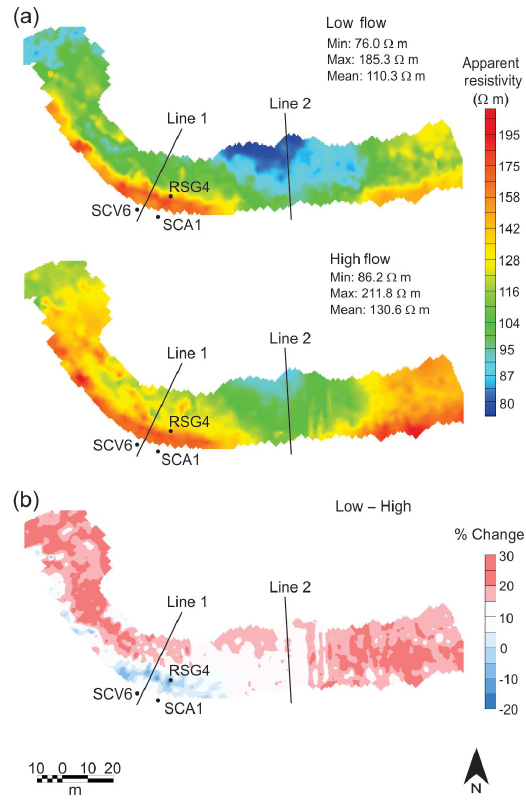
Figure 8. Riverbed resistivity obtained using an EM-31 ground conductivity meter during low-flow (low-stage) conditions on 7 July 2014 and high-flow (high-stage) conditions on 3 April 2013. (b) Percentage change in apparent resistivity from low- to high- stage